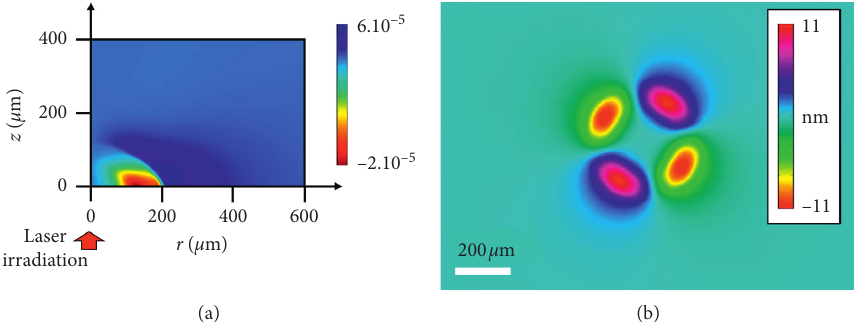
Figure 2: Experimental and simulation results of residual stress measurement of fused silica treated with laser. (a) Calculated birefringence distribution after irradiation. (b) Simulated retardation cartography [24].